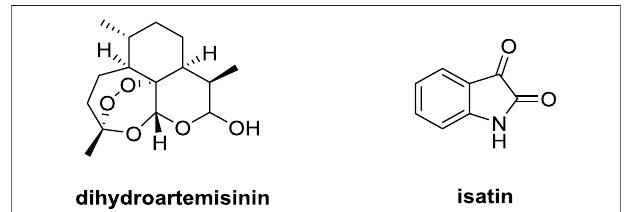
FIGURE 1 | Chemical structures of dihydroartemisinin and